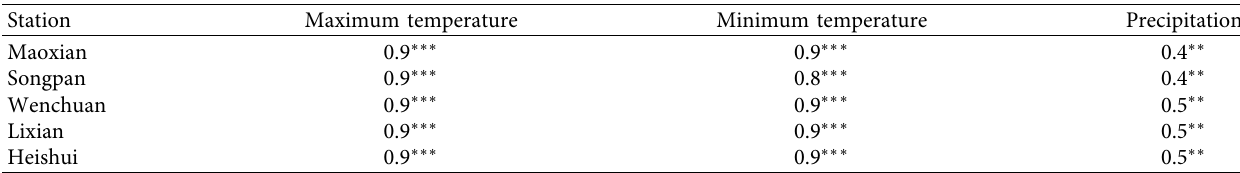
Table 5: Correlation coefcients of measured and simulated daily maximum and minimum temperature and precipitation during the verifcation period.